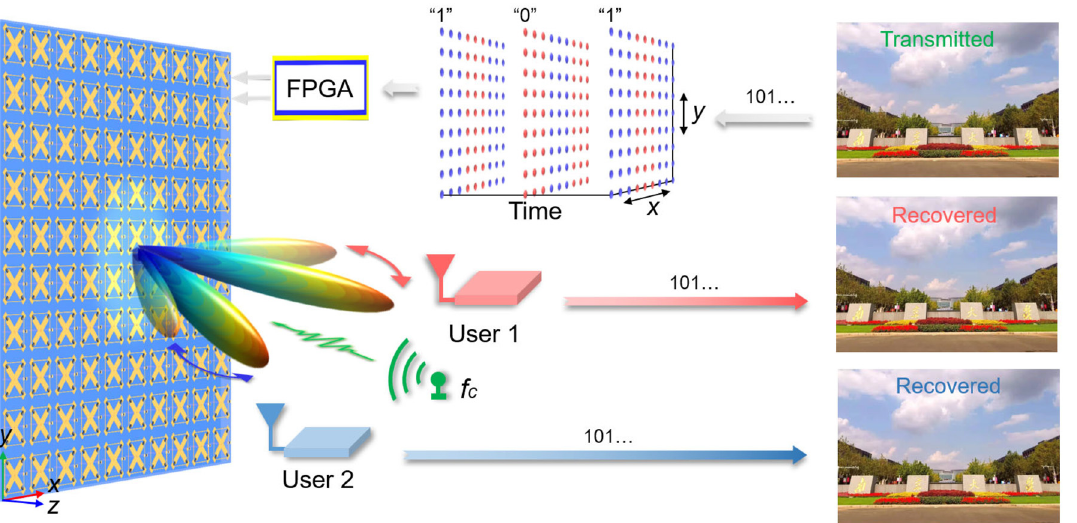
Figure 1: Conceptual illustration of the broadband wireless communication system with beam-steerable capability based on the space-time-varying metasurface. By modulating the metasurface with time-varying spatial patterns translated by the transmitted information, highly directive beams are simultaneously generated to enhance regional signals and reduce signal leakage in undesired directions, customized for time-division multiuser